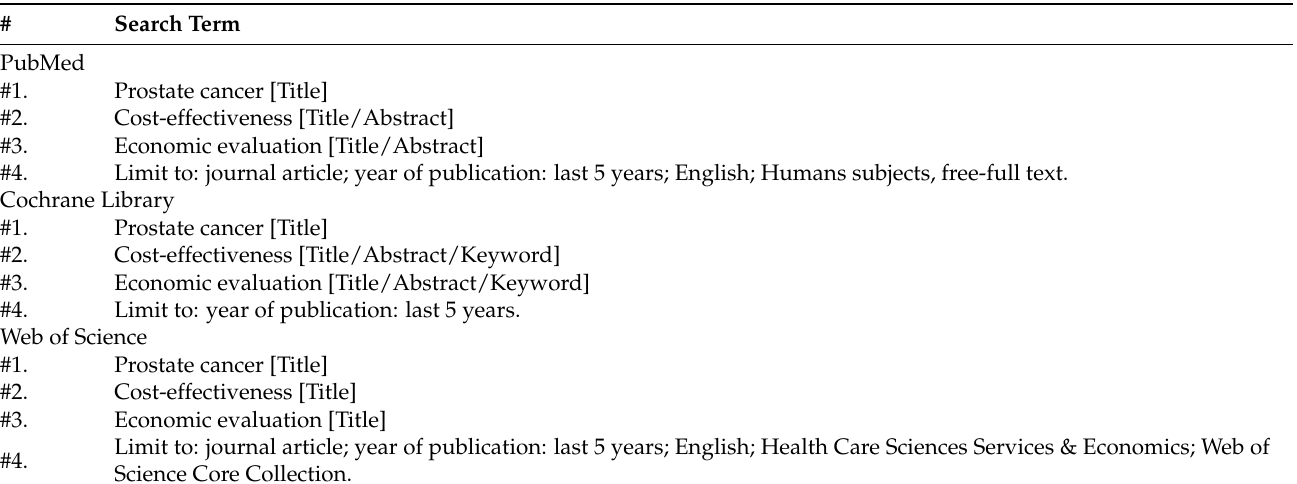
Table 1. Search strategy for study selection from PubMed, Cochrane Library, and Web of